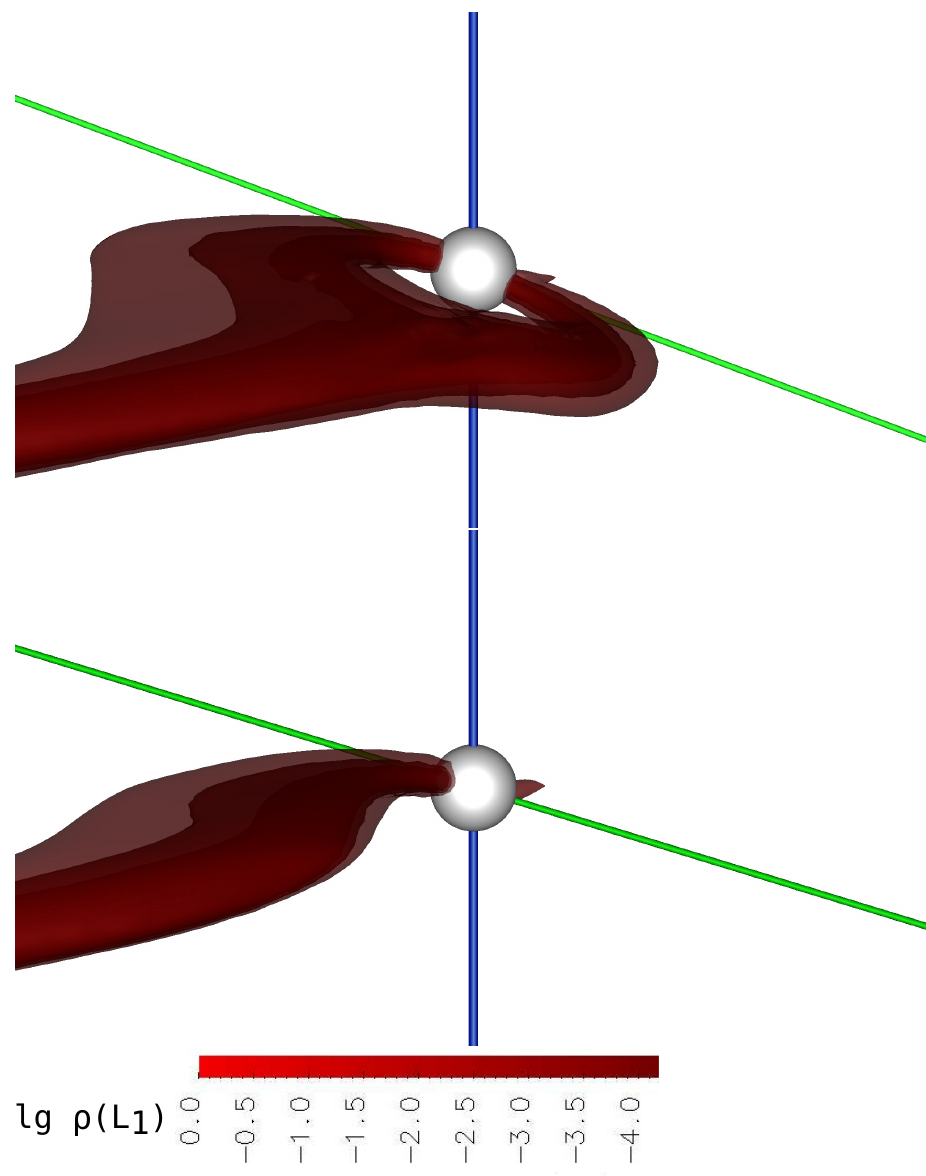
Figure 7. The same as in Figure 6, but for Phase 3 ( upper panel)) and Phase 4 ( lower